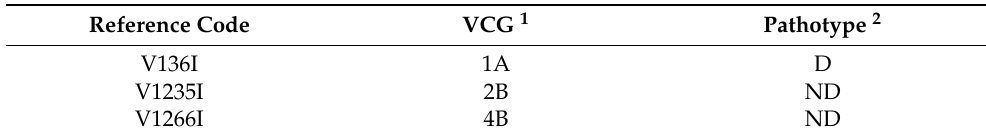
Table 1. Verticillium dahliae isolates used in this study, along with reference code, vegetative compati- bility grouping (VCG) and